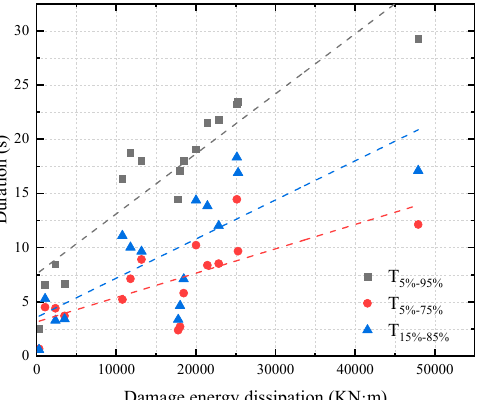
Figure 8. The accumulated damage crack patterns of the concrete lining under the different duration of NFGMs. (a) San Fernando, (b) Coyote Lake, (c) Imperial Valley-06 (Aeropuerto Mexicali), (d) Imperial Valley-06 (Brawley Airport), (e) Imperial Valley-06 (El Centro Array #11), (f) Imperial Val- ley-06 (El Centro Array #3), (g) Imperial Valley-06 (El Centro Differential Array), (h) Mendocino, (i) Landers (Barstow), (j) Landers (Yermo Fire Station), (k) Northridge-01, (l) Kocaeli, (m) Chi-Chi